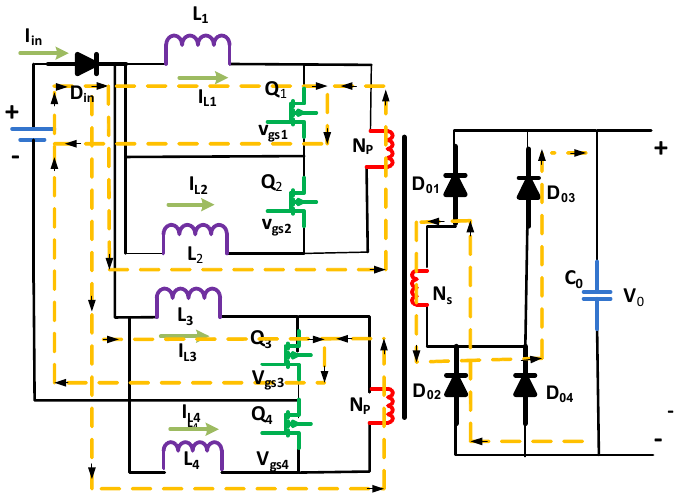
Figure 3. First mode of the circuit.